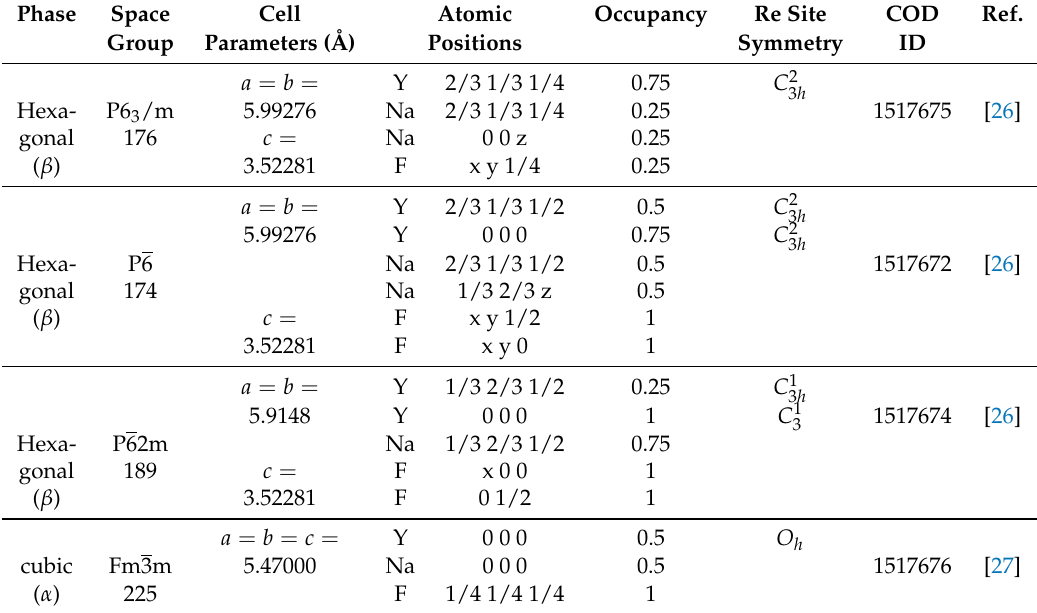
Table 2. Crystallographic data on synthesized phases of NaYF 4 for phase identification and rare-earth (Re) ion site